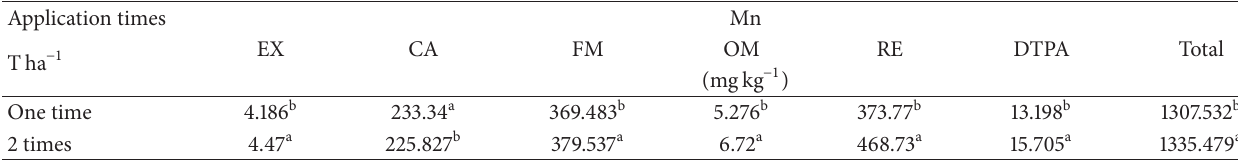
Table 4: Mean comparison of total and DTPA-extractable concentrations and existing amounts in 5 different soil fractions for Mn, respectively, at application